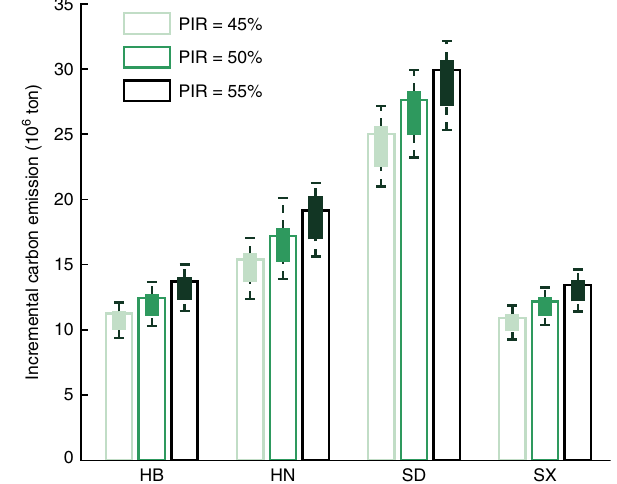
Fig. 1 Carbon emission estimation in Hebei (HB), Henan (HN), Shandong (SD), and Shanxi (SX) provinces after implementing Electric Heating Policy in 2015. Each three bars for a province represent the incremental carbon emissions with an average electric heating mix when the policy implementation rate (PIR) equals 45%, 50%, and 55%, respectively. Each box represents the incremental carbon emission acquired by scanning the electric heating mix ( n = 12). The minimum/maximum of each box indicates the minimal/maximal value of incremental carbon emission, and the lower and upper percentiles are 25% and 75%,